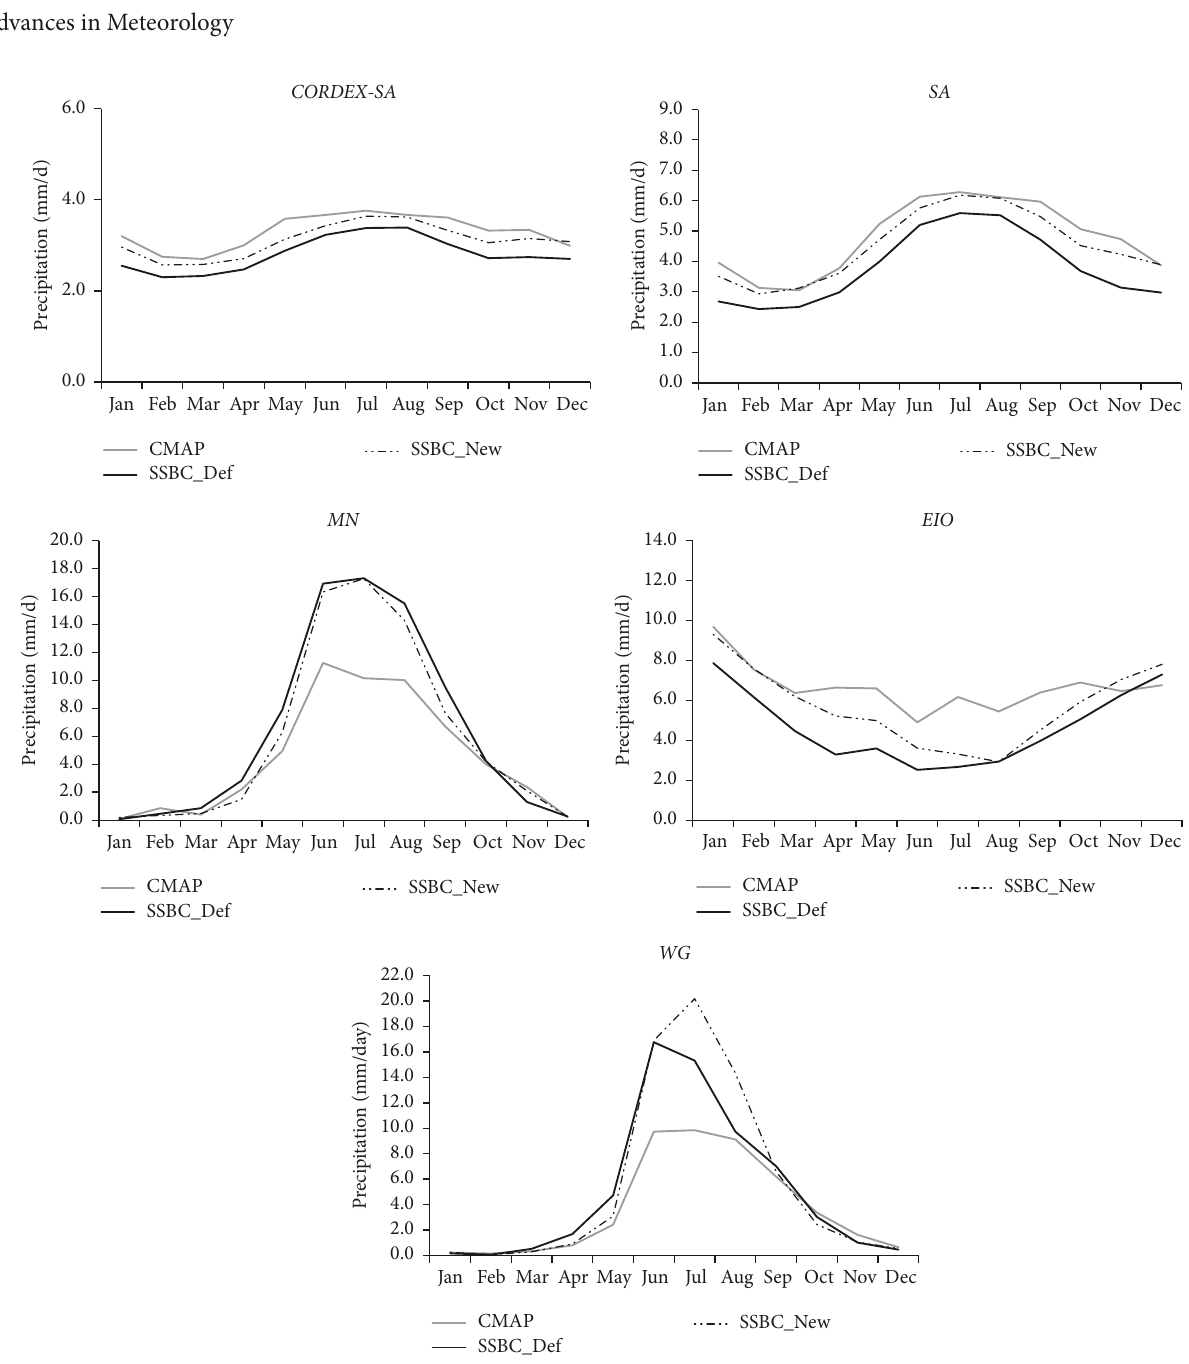
Figure 7: Comparison of seasonal variabilities of surface precipitation (mmd – 1 ) among CMAP (grey solid line), SSBC_Def (black solid line), and SSBC_New (black dot dash line) for the CORDEX-SA and its subdomains for years